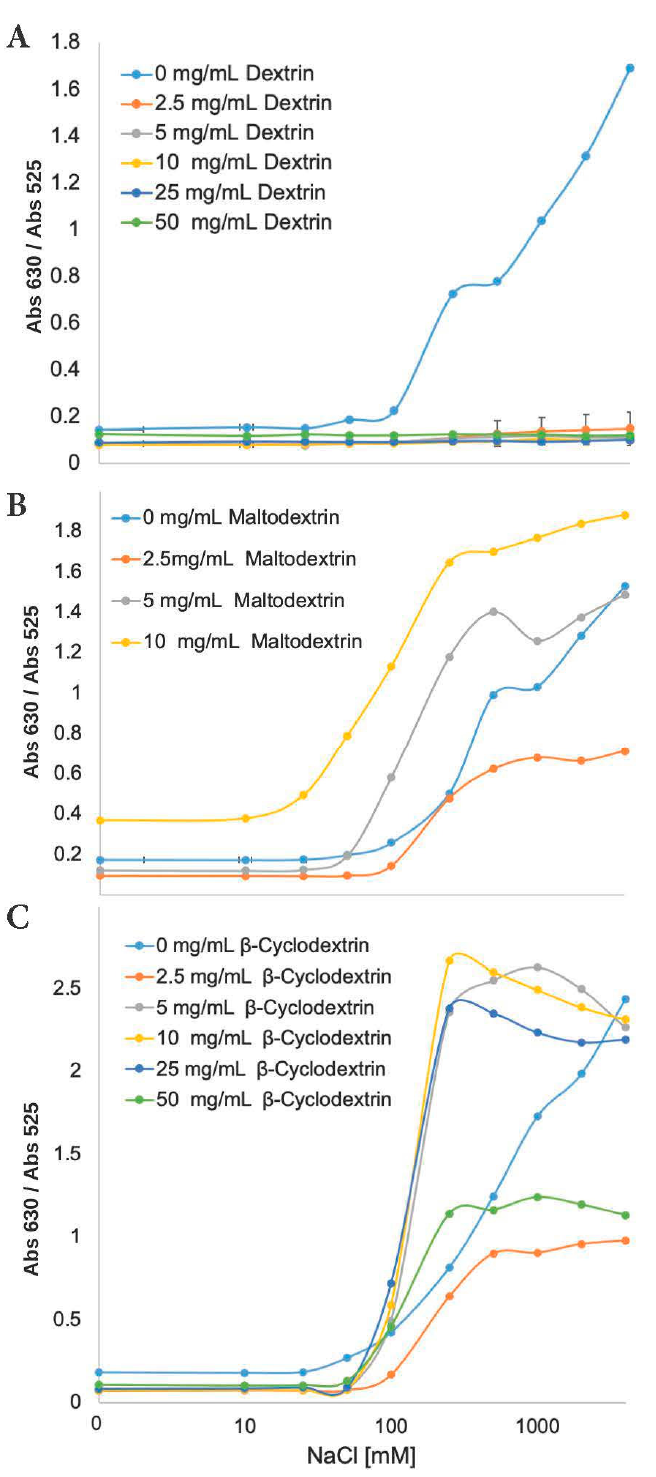
Figure 7. Plots of Abs 630 /Abs 525 ratio of AuNPs in three different polysaccharide hydrogels suspension. ( A ) Dextrin, ( B ) Maltodextrin and ( C ) β -Cyclodextrin. Each sample was run at five different concentrations of polysaccharides versus known concentration of NaCl.